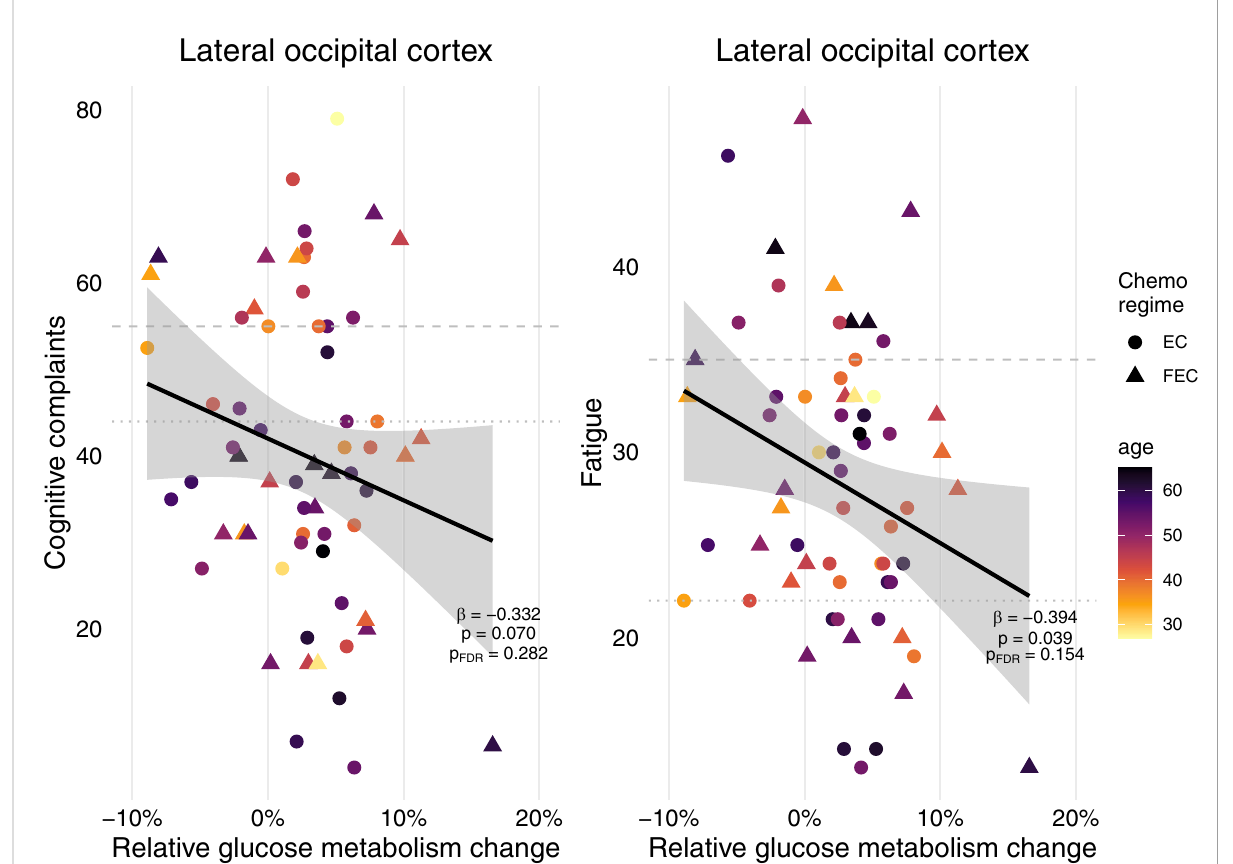
FIGURE 4 Self-report cognitive complaints and fatigue of patients treated for breast cancer with chemotherapy and their metabolic associations. Relative metabolic changes in the lateral occipital cortex preceded fatigue years later, but not cognitive complaints. After FDR-correction, this association disappeared. No associations were found for changes in the frontal cortex (paracingulate cortex, pericentral gyri) or basal ganglia (putamen), nor for absolute baseline metabolism in any of these regions or having received additional radiotherapy, endocrine therapy and/or HER2 therapy ( n =64). Final linear models included chemo regime and were corrected for age, and years since treatment. Striped line = extreme cognitive complaints/fatigue, dotted line = cognitive complaints/fatigue. EC = 4 rounds of epirubicin 90 mg/m 2 + cyclophosphamide 600 mg/ m 2 ; FEC = 3-6 rounds of 500 mg/m 2 5- fl uorouracil and 4 rounds of epirubicin 100 mg/m 2 + cyclophosphamide 500 mg/m 2